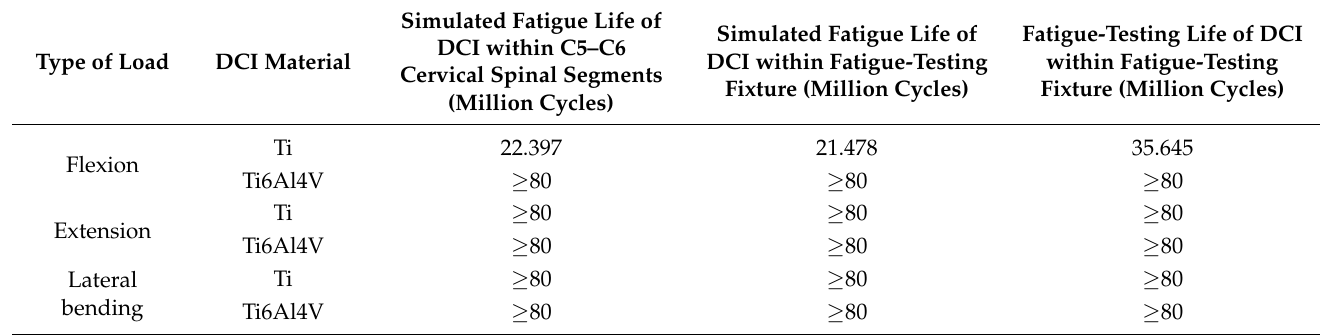
Table 2. Simulated fatigue results and fatigue-testing